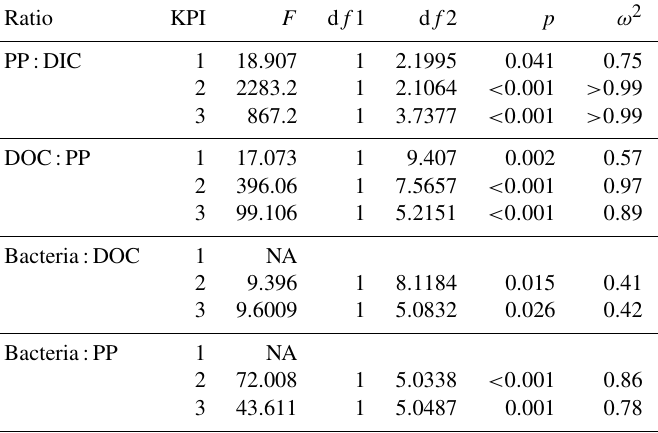
Table B2. Welch ANOVA results of 14 C flow (Table 2). Each line presents the test of difference between the phytoplankton species for the given ratio at the given